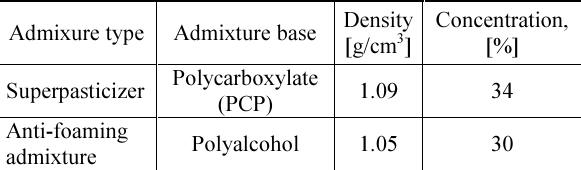
Fig. 9. The differences in side porosity of hardened mortar with a SP (a) and SP with the type f AFA (b)